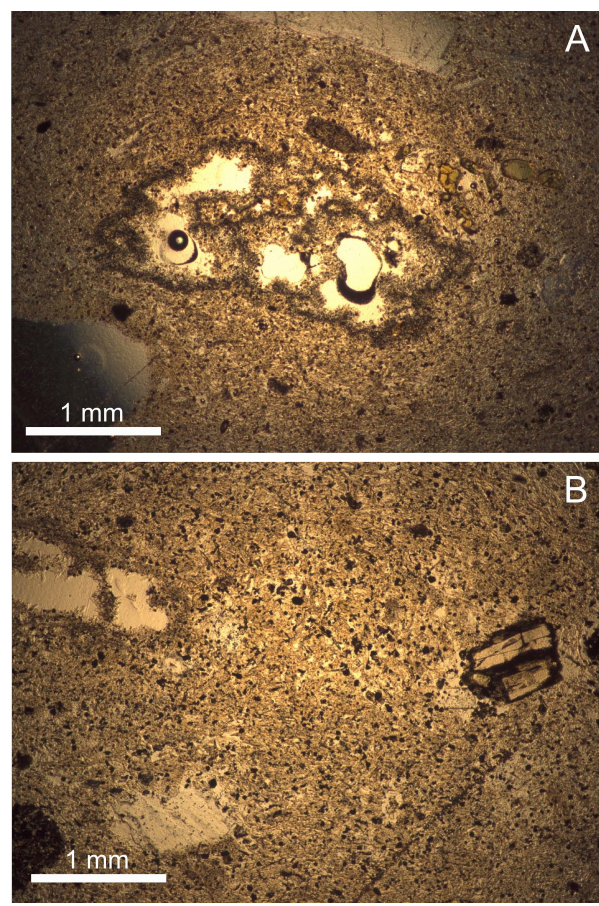
Fig. 13. Optical microscope images of Grey Campanian Ignimbrite thermally stressed to a temperature of 1000 ◦ C. Both photographs are taken from Heap et al.